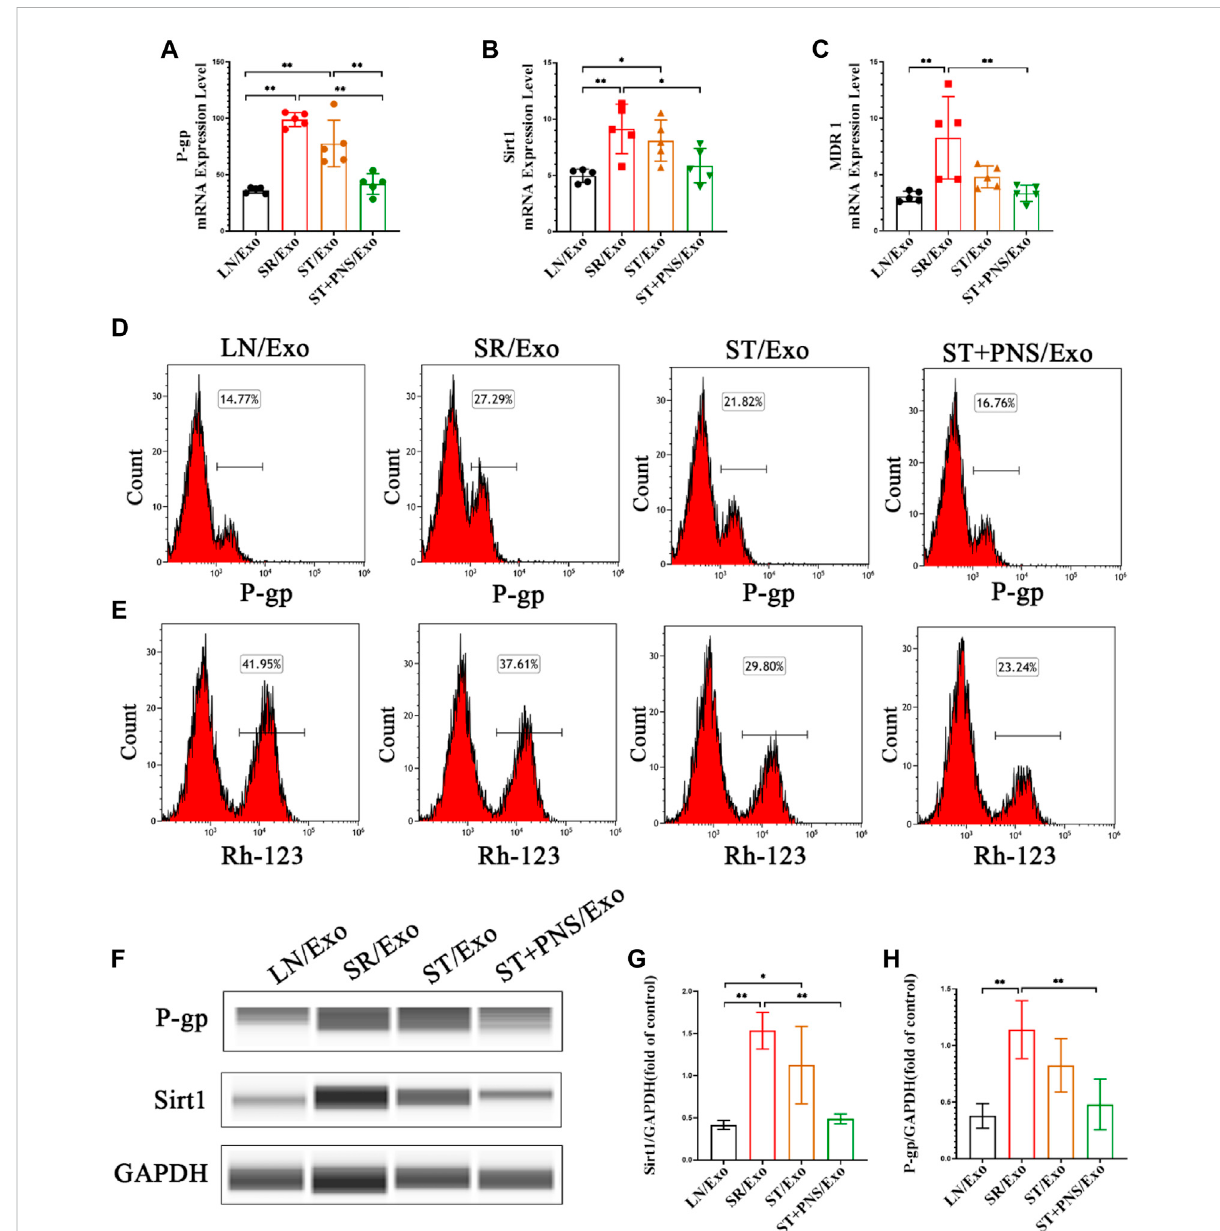
FIGURE 5 Expression of steroid resistance-related indicators in each group of GECs extracted after different Lyme-Exo interventions. (A – C) Detection of themRNAexpressionof Sirt1,MDR1 and P-gp byqRT-PCR. (D,E) FlowcytometrydetectionofP-gplevelsandaccumulationofRh-123ineachgroup of GECs. (F – H) Sirt1 and P-gp protein levels in GECs were detected by capillary immunoassay. All data are expressed as the mean ± standard deviation from independent groups, *p < 0.05, ** p <